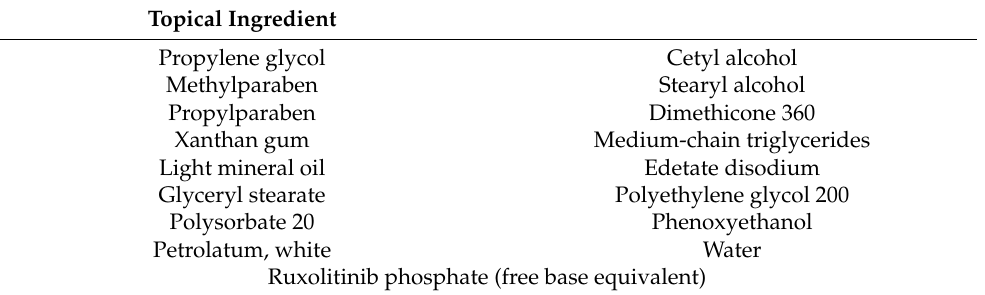
Table 1. Ruxolitinib topical composition